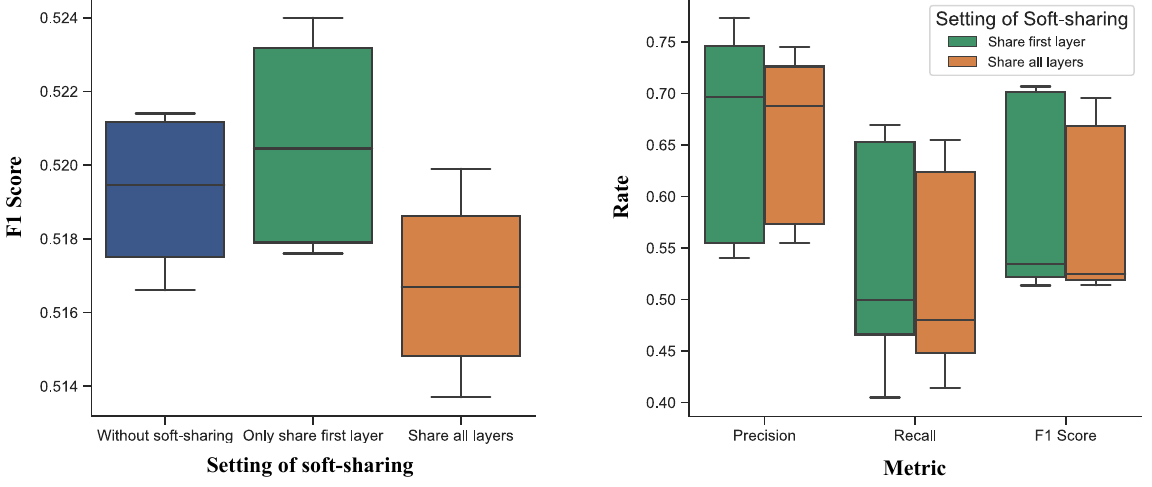
Figure 6. ( a ) F1 score for different soft-sharing settings in emotion–cause pair extraction tasks. Soft sharing of first layer parameters is far better than not sharing. ( b ) A detailed comparison of the performance of soft sharing one layer and sharing all layers under different metrics. More layers of soft-sharing parameters do not directly lead to better